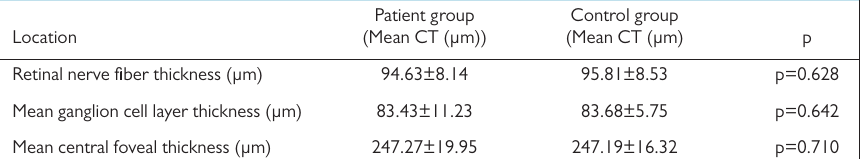
Table 2. The comparative values of retinal nerve fiber, mean ganglion cell layer, and mean central foveal thickness for the patient and control